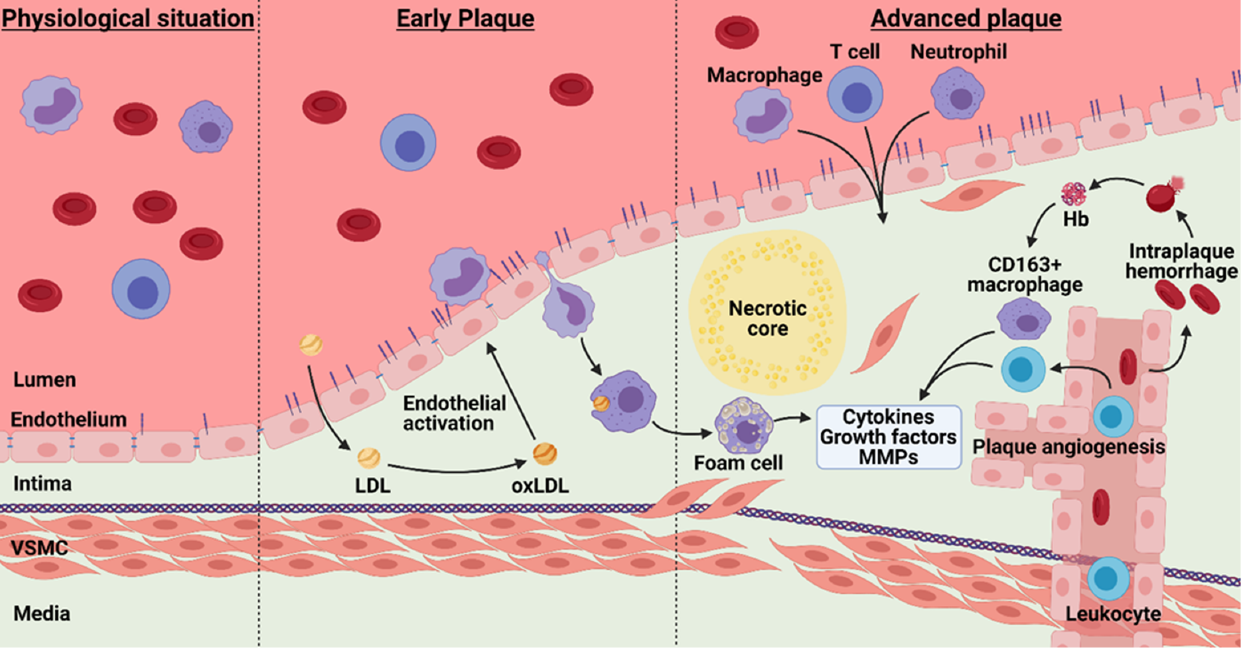
Figure 3. Pathophysiology of early and advanced atherosclerosis. Upon transcytosis and oxidation of LDL, the endothelium becomes activated leading to leukocyte infiltration into the vessel wall. This triggers thickening of the intimal layer, ultimately resulting in foam cell accumulation and necrotic core formation. Hypoxia induces intra-plaque angiogenesis, but these neovessels are often mature which leads to intraplaque hemorrhage and excessive extravasation of leukocytes. This results in production of cytokines, growth factors and MMPs, creating a continuous loop of plaque growth and ultimately plaque rupture. Hb—hemoglobin; LDL—low-density lipoproteins; MMPs—metallo matrix proteinases; oxLDL—oxidized low-density lipoproteins; VSMC—vascular smooth muscle